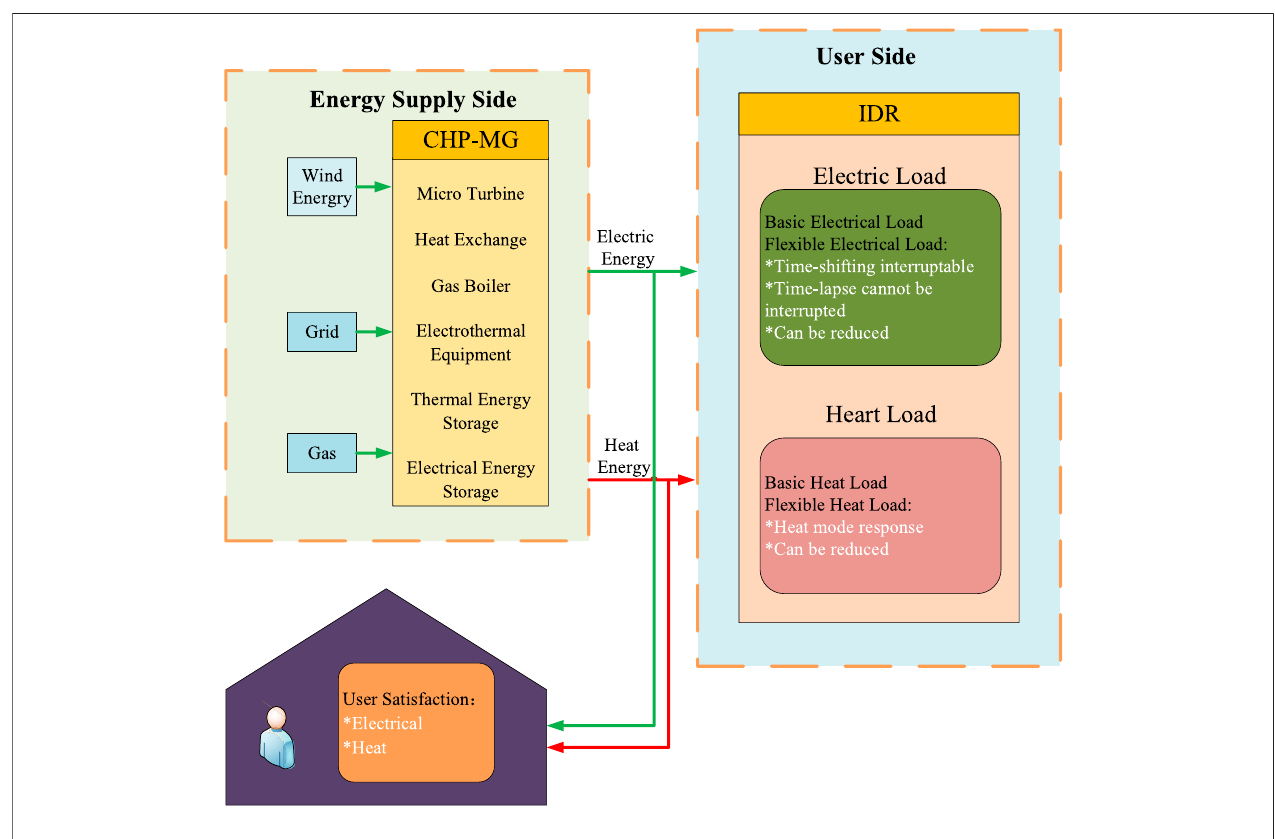
FIGURE 1 | System overall framework